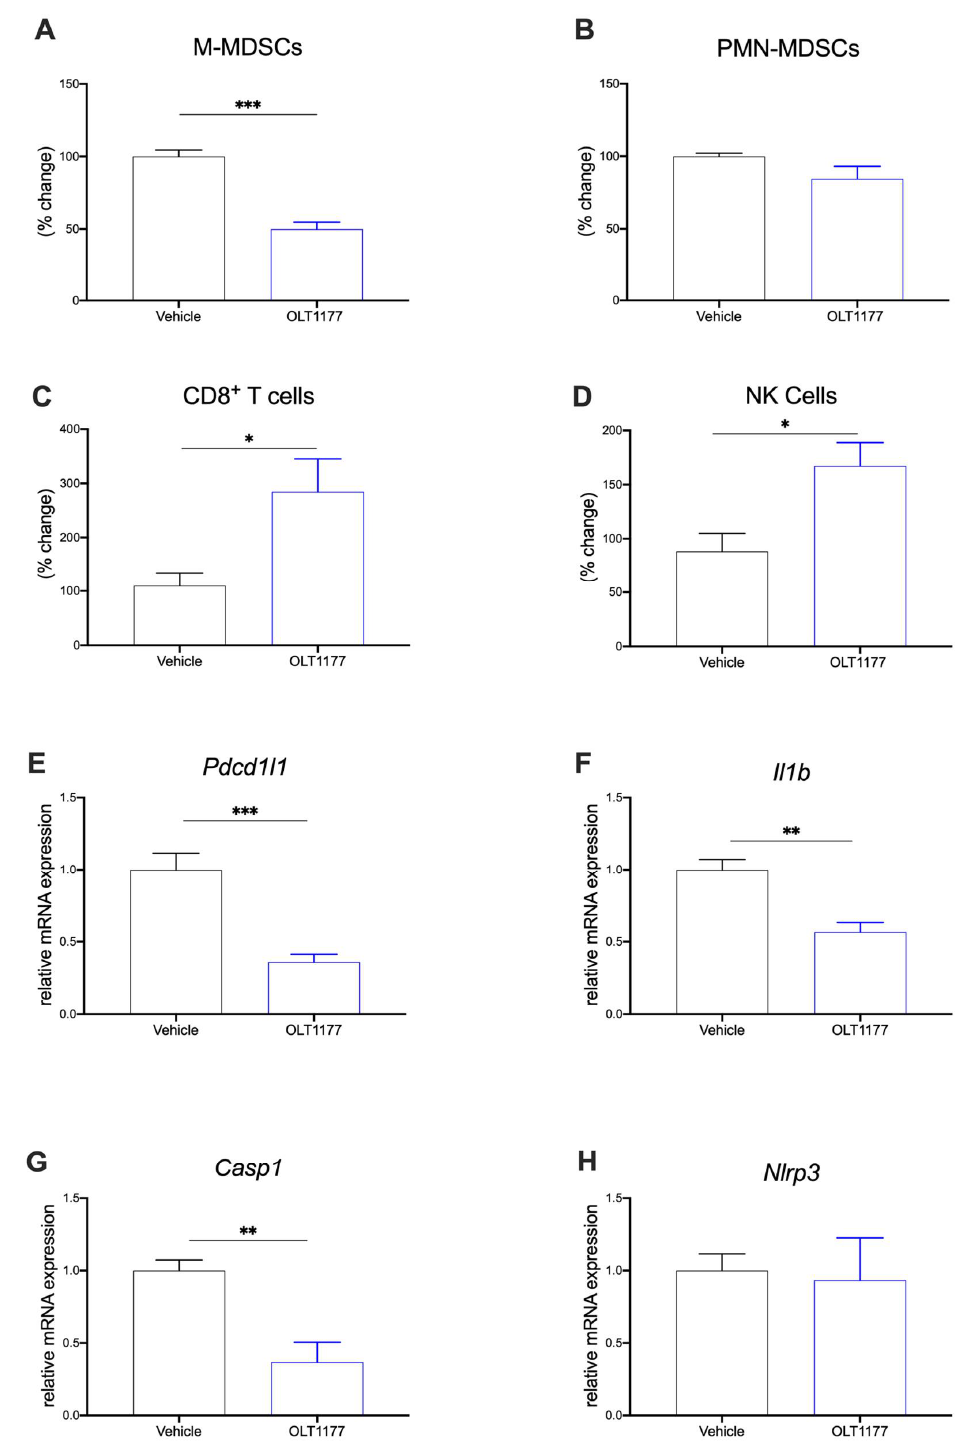
Figure 3. NLRP3 drives immunosuppressive TME. ( A – D ) Flow cytometry analysis of primary tumors in mice fed standard or OLT1177 diet. ( A ) Levels of M-MDSC in primary tumors of mice fed standard or OLT1177 diet ( n = 5). ( B ) Levels of PMN-MDSC in primary tumors of mice fed standard or OLT1177 diet ( n = 5). ( C ) Levels of CD8 + T cells in primary tumors of mice fed standard or OLT1177 diet ( n = 5). ( D ) Levels of NK cells in primary tumors of mice fed standard or OLT1177 diet ( n = 5). ( E – G ) Mean ± SEM of relative mRNA expression of Pdcd1l1 (E), Il1β ( F ), Casp1 ( G ) and Nlrp3 ( H ) from primary 4T1 tumors in mice fed standard or OLT1177 diet ( n = 6). *** p < 0.001, ** p < 0.01, * p <